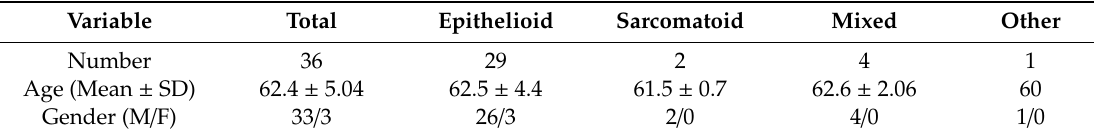
Table 1. Characteristics of mesothelioma patients.